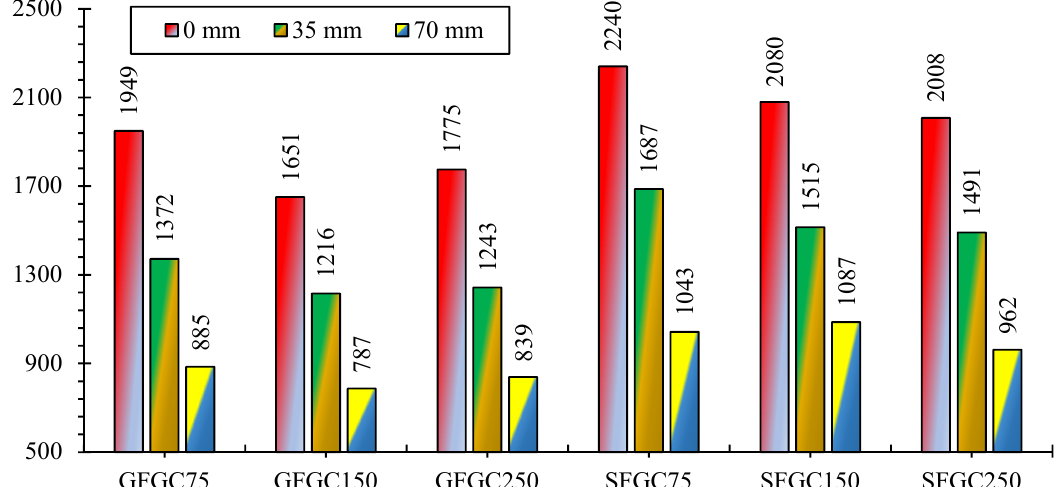
Figure 13. Influence of eccentric loading on the AST of Figure 13 . Influence of eccentric loading on the AST of samples.